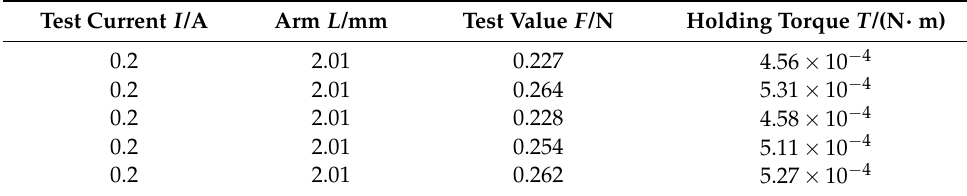
Table 7. Stepper motor holding torque test